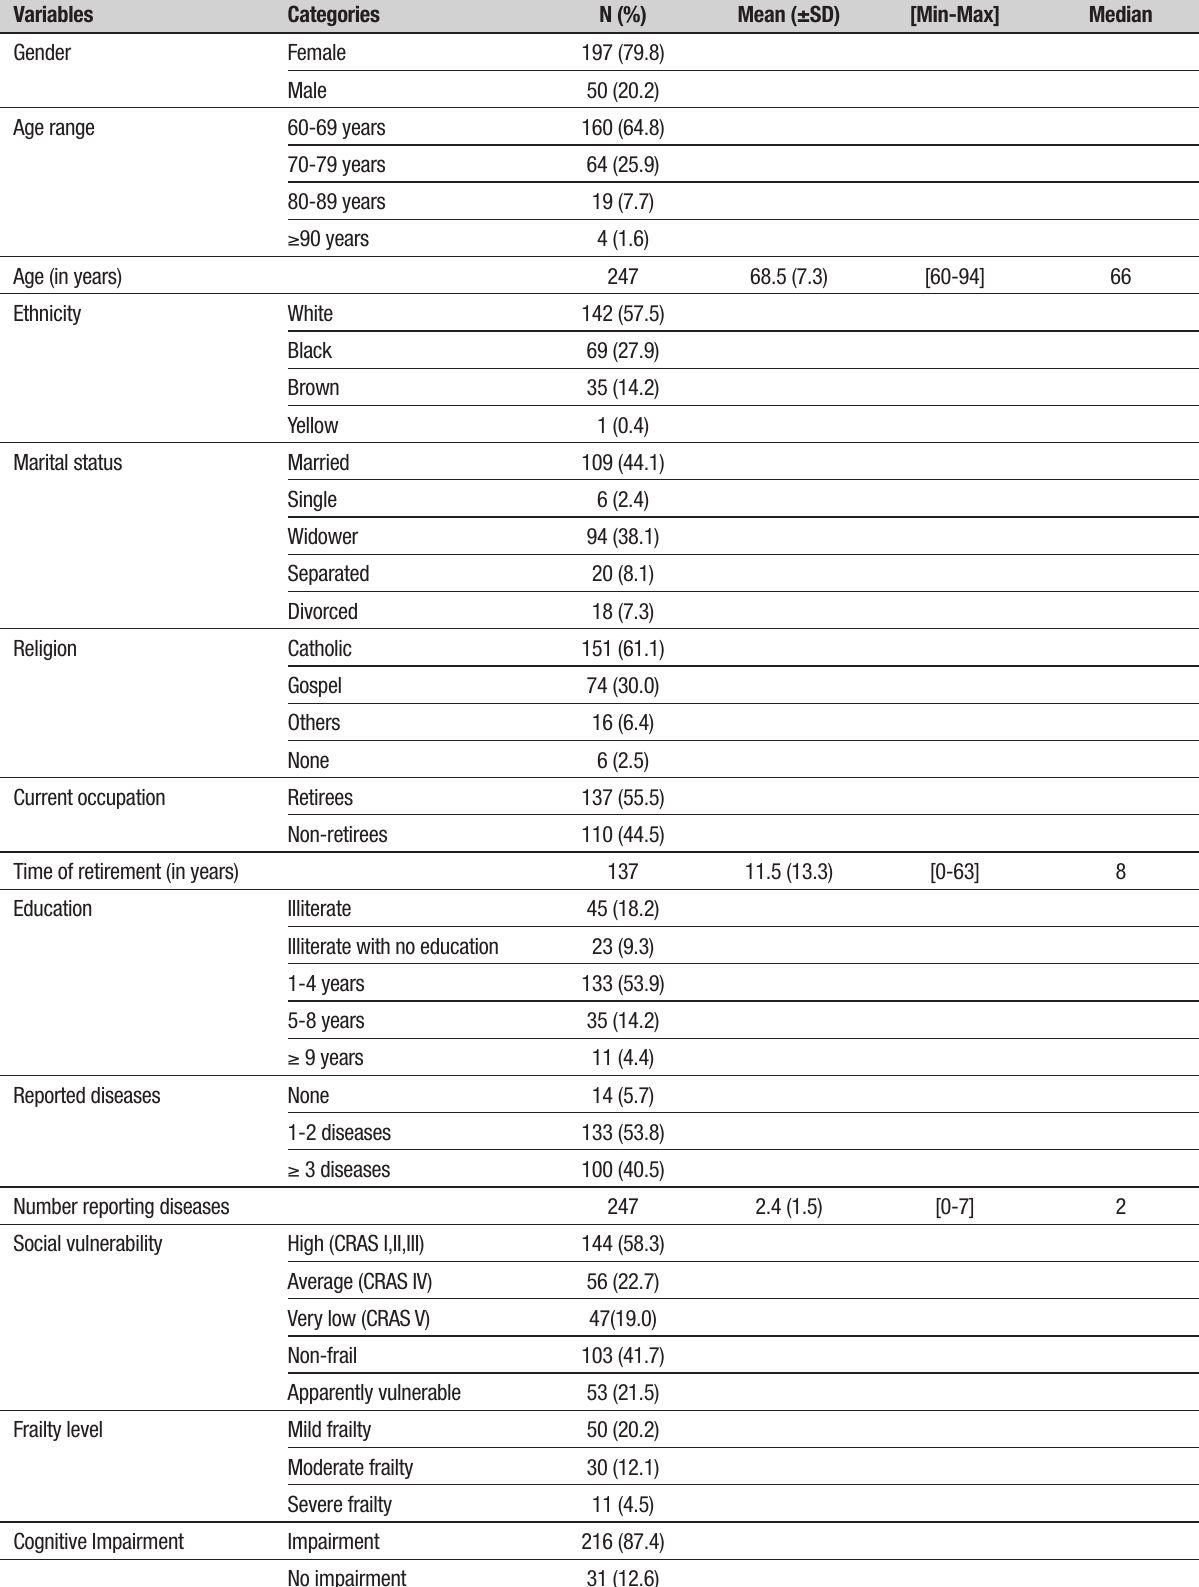
Table 1. Distribution of sociodemographic characteristics, vulnerability, frailty and cognition of elderly registered at CRAS. São Carlos, SP, 2016 (n=247).